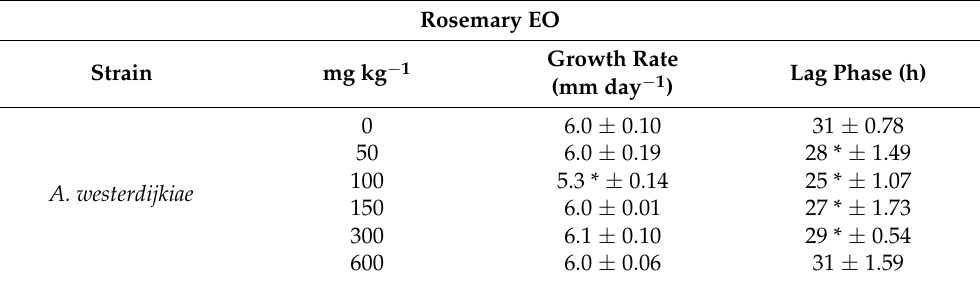
Table 3. Effect of rosemary essential oil on the lag phase and growth rate of A. westerdijkiae at different concentrations.